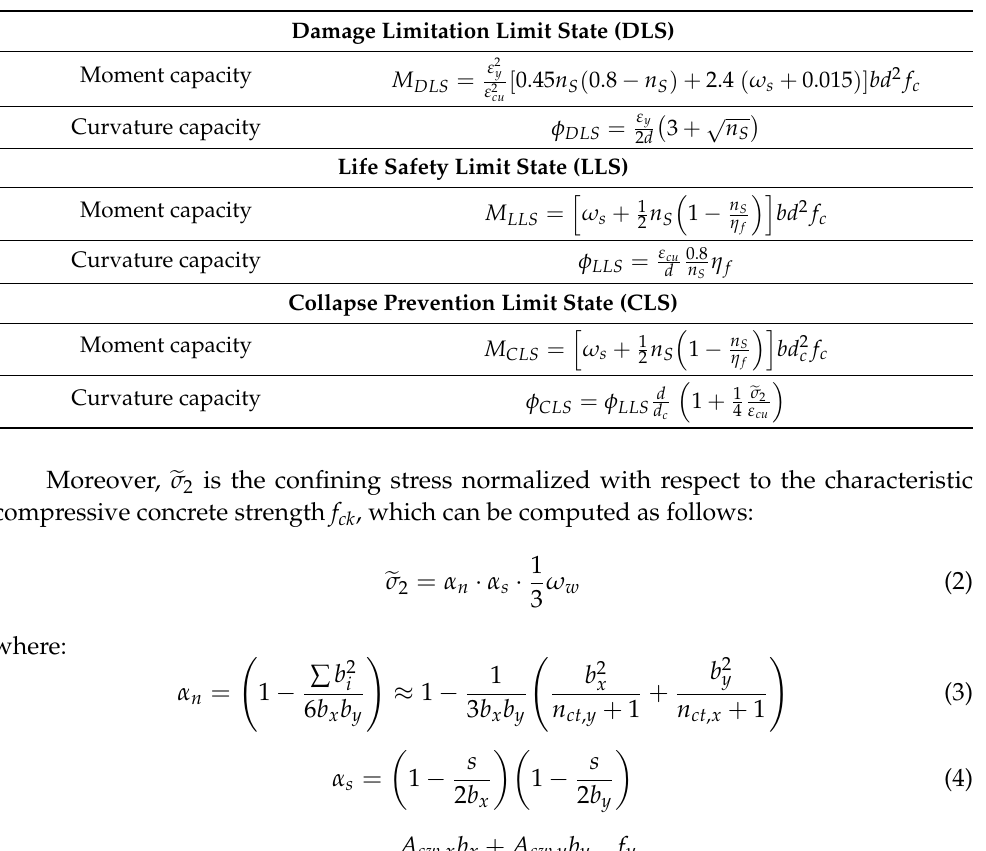
Figure 2. Moment-curvature relationship of a column section with the corresponding limit state criteria for Damage limitation Limit State (DLS, tension steel yielding), Life safety Limit State (LLS, concrete cover crushing), and Collapse prevention Limit State (CLS, concrete core crushing). Table 1. Equations for moment and curvature capacity at three LSs for the case of rectangular sections with symmetric